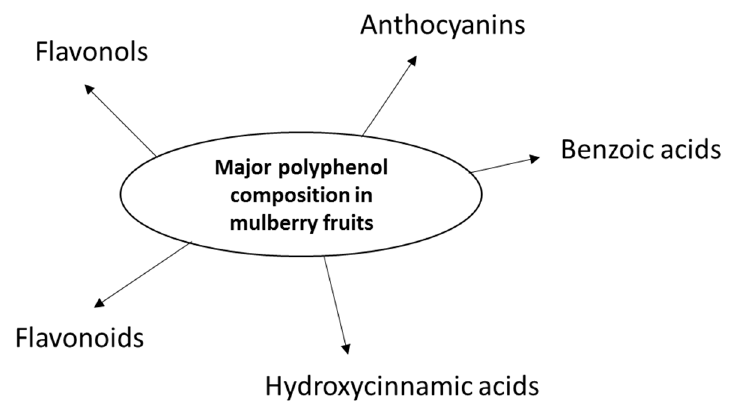
Figure 1. Major polyphenol composition in mulberry fruits.